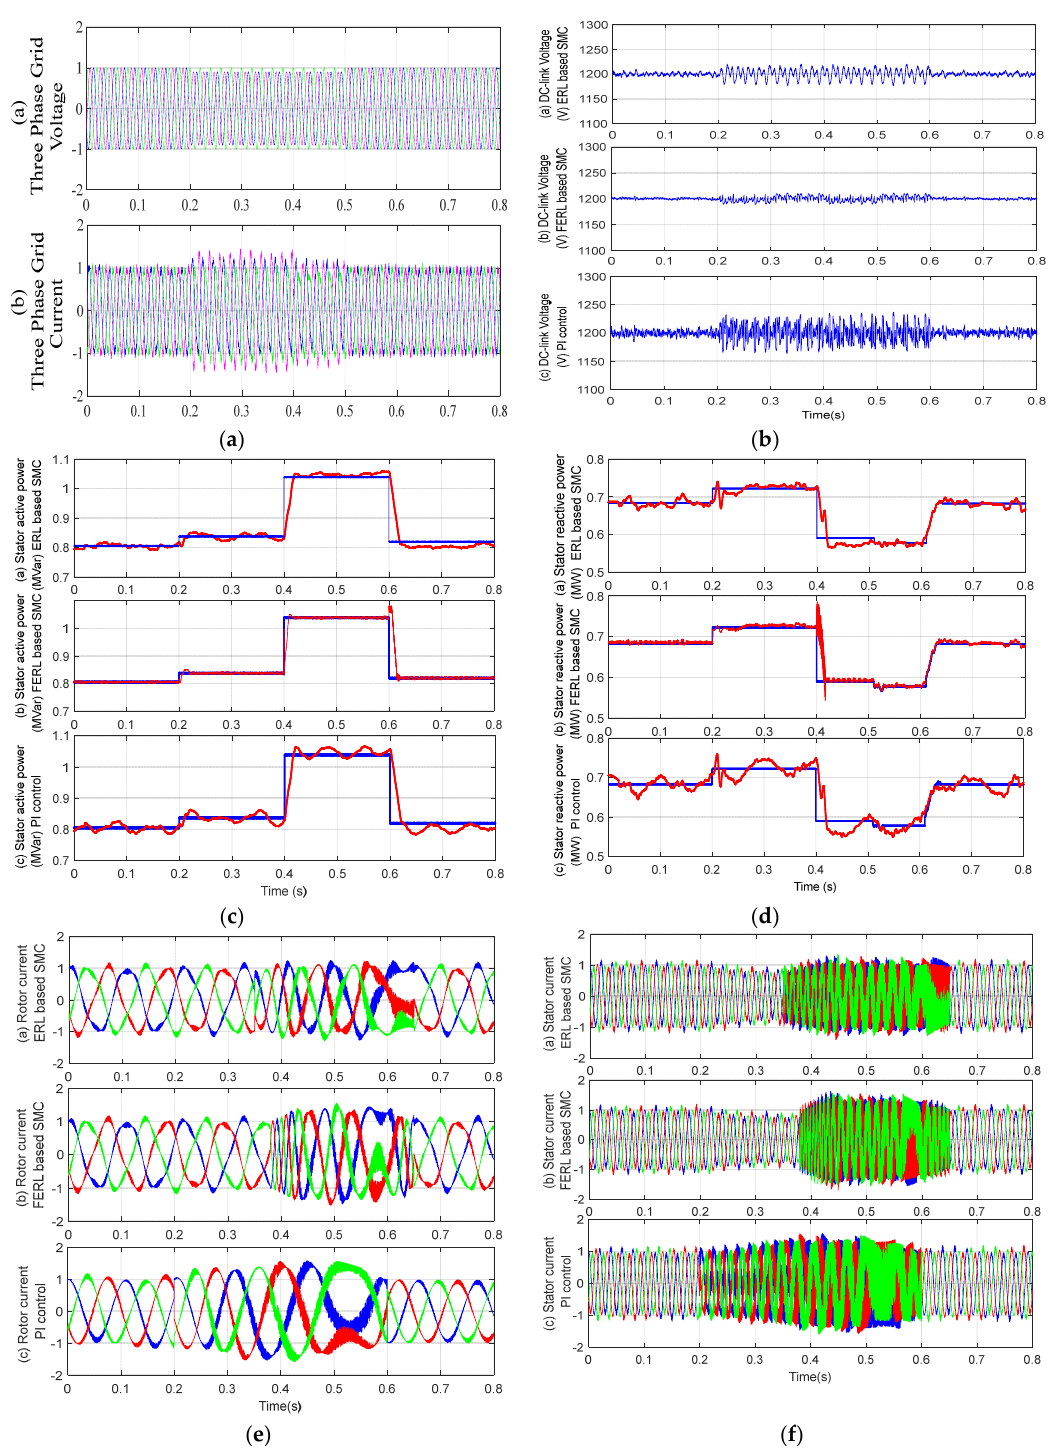
Figure 7. Simulation results with grid voltage drop/gust wind comparing three different approaches: ( a ) three phase grid voltage and current; ( b ) DC ‐ link voltages; ( c ) Stator active power performances; ( d ) Stator reactive power performances; ( e ) Rotor currents; ( f ) Stator currents).